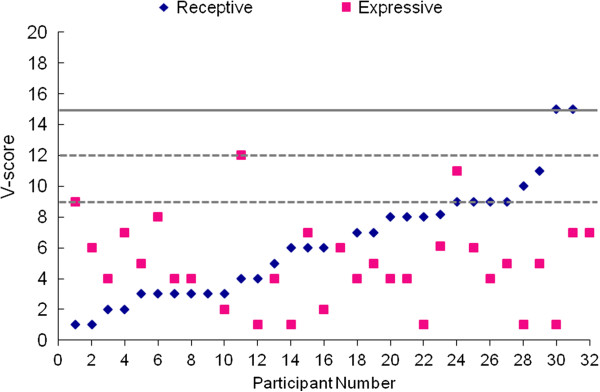
Language functioning based on Vineland Adaptive Behavior Scales (n = 32) represented by V scores. Population mean (15) and standard deviation (3) are represented by solid and dashed lines, respectively.